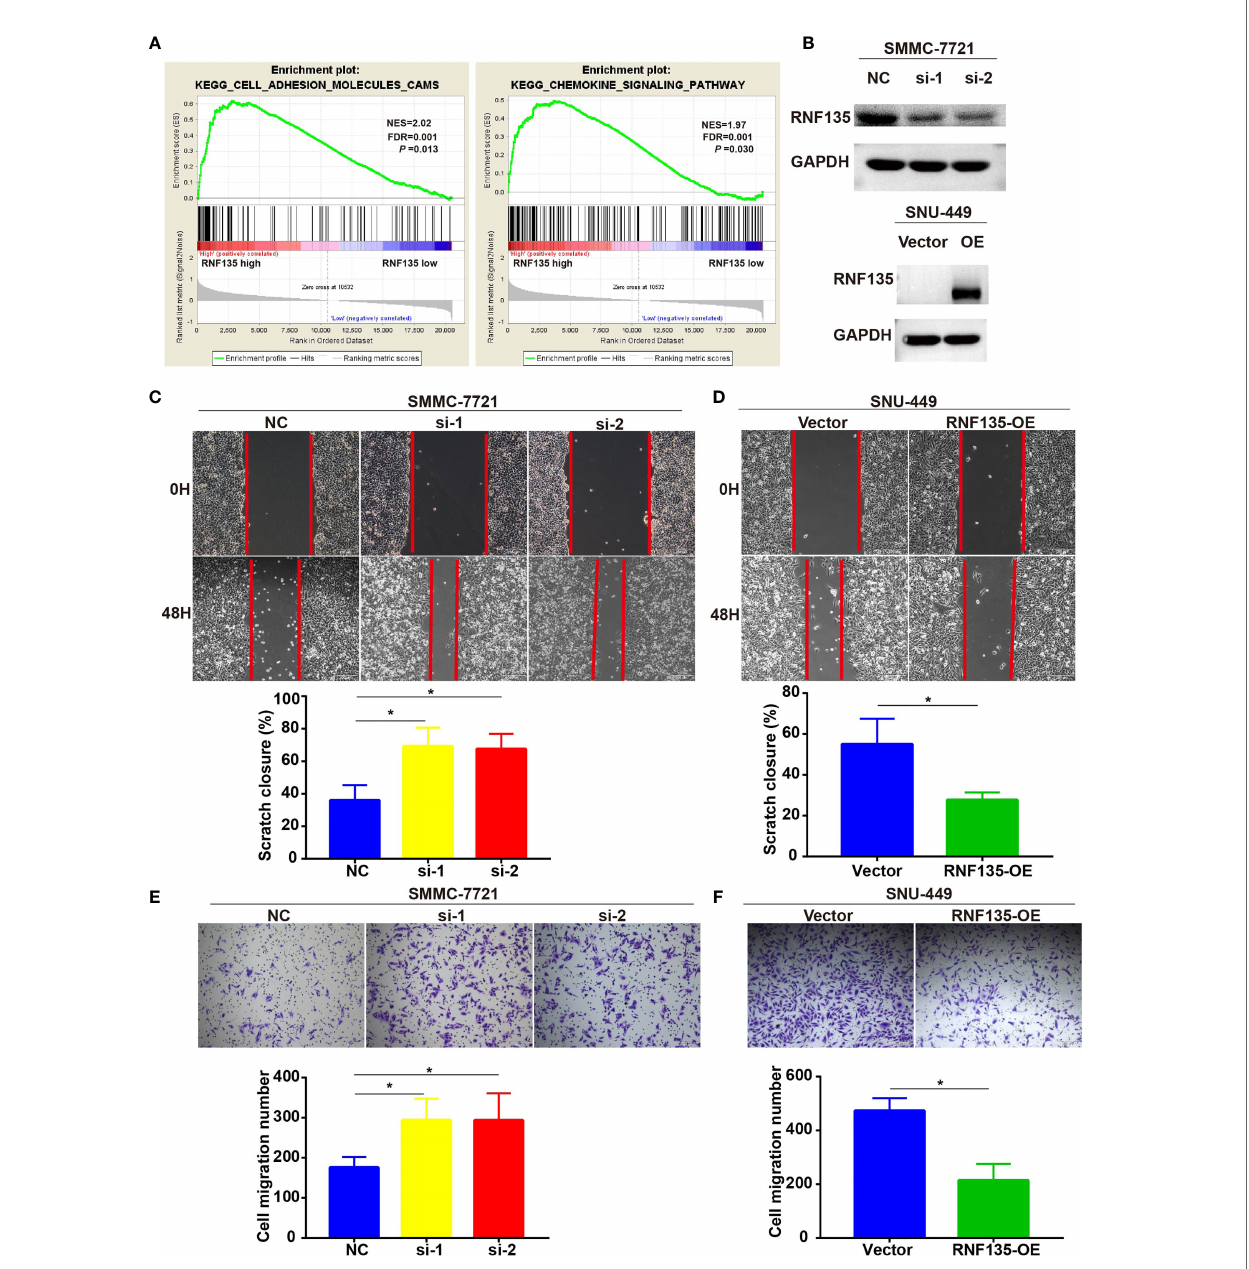
FIGURE 3 | The effects of RNF135 expression on cell migration and invasion. (A) RNF135 related pathways in HCC patients were analyzed by GSEA. (B) Knockdown and overexpression ef fi ciency of RNF135 in cell lines was measured by western blot. (C, D) Wound healing assay was used to detect cell migration (up), and Student ’ s t-test for unpaired was applied between experimental group and control group (down). (E, F) Transwell assay was used to evaluate cell invasion (up), and Student ’ s t-test for unpaired was applied between experimental group and control group (down). All experiments were repeated three times, and data were expressed as mean ± SD. * P <